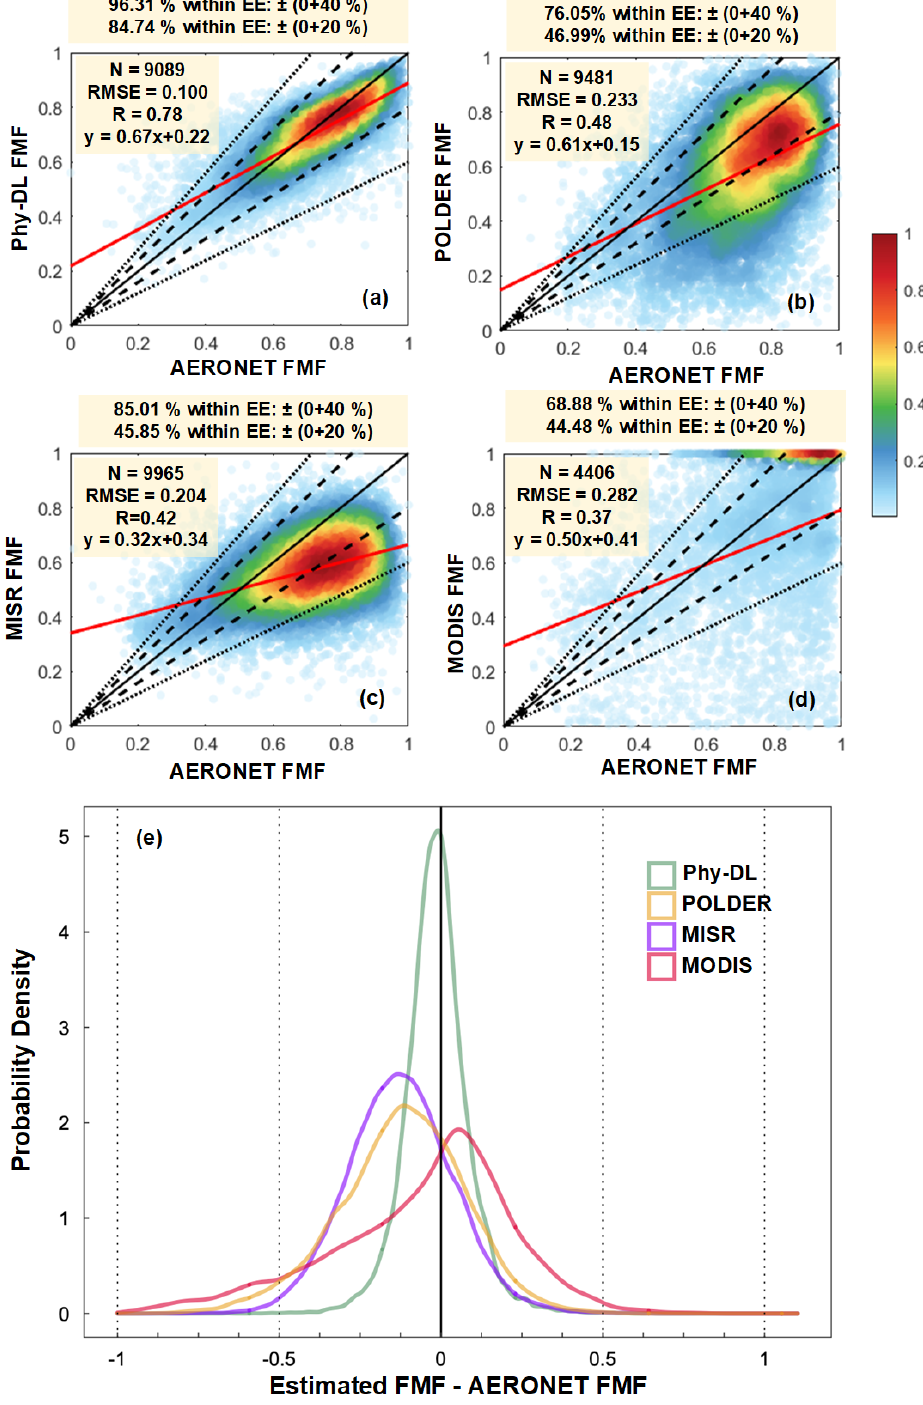
Figure 10. Evaluation of (a) Phy-DL (550nm), (b) POLDER (490nm), (c) MISR (550nm), and (d) MODIS FMFs (500nm) against AERONET FMF (500nm) from 2008 to 2013. Solid black and red lines are 1 : 1 reference lines and best-fit lines from linear regression, respectively. Dashed and dotted black lines represent the EE envelopes of ± 20% and ± 40%, respectively. The number of samples ( N ), RMSE, correlation coefficient ( R ), and linear regression relation are given in each panel. (e) Probability density functions of the FMF bias (estimated FMF minus AERONET FMF) for Phy-DL (green), POLDER (orange), MISR (blue) and MODIS (red) FMFs.